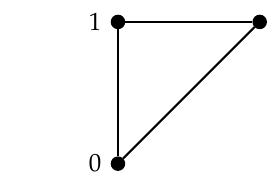
Figure 4. SBGs of G and G (cid:48) associated with H and H (cid:48) .